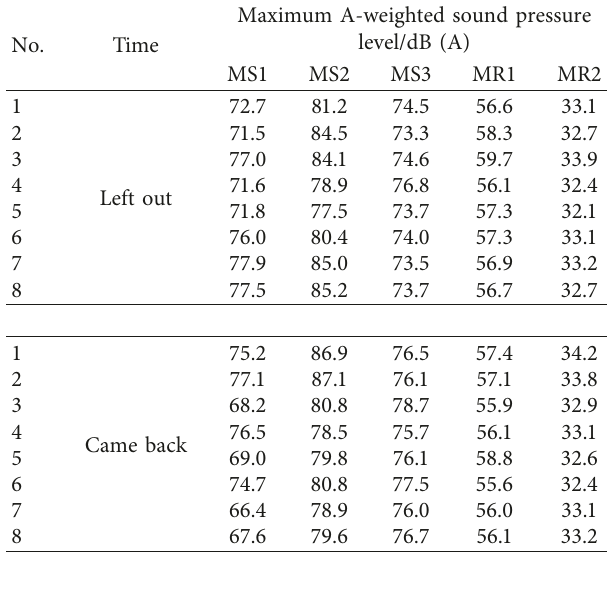
Table 2: The maximum A-weighted sound pressure level per each pass-by.